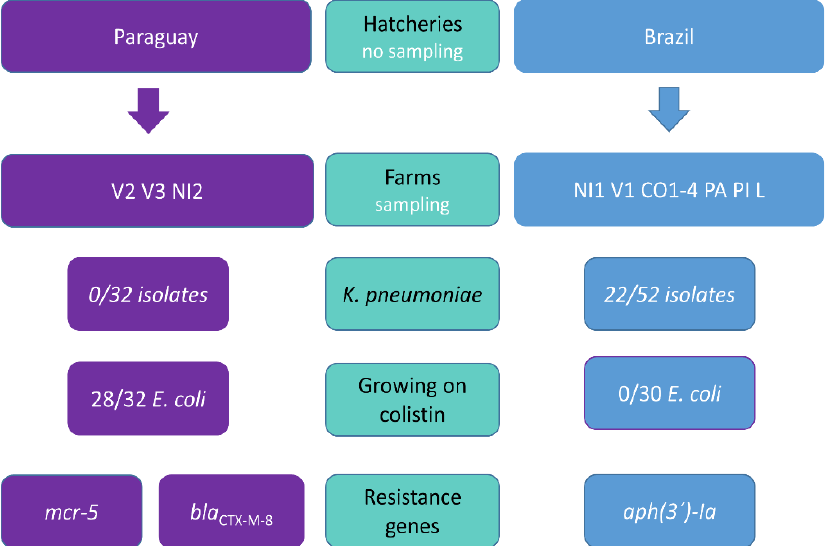
Figure 3. Phylogeny of selected K. pneumoniae isolates from Paraguayan farms. The columns isolate name (consist of the sample number and “me” for selection using meropenem and “e” for selection using cefotaxime); sequence type, hatchery (Br–Brazil); farm (label consist of the village name and farm number: Villeta: V1; Nueva Italia: NI1; Colonel Oviedo CO1– 3; Piribebuy: PI; Luque: L). The color squares indicate presence of selected antibiotic resistance genes (purple-pink), F plasmid replicons (blue) and other plasmids (turquoise). The color circles indicate transferability of ESBL genes (pink) in conjugation experiments, full circles mean the conjugation was successful including confirmation of presence of respective genes by PCR, empty circles represent unsuccessful conjugation. For the single-plasmid fully typed transconjugants, the information which plasmid replicon carries the respective gene is presented next to the circle.